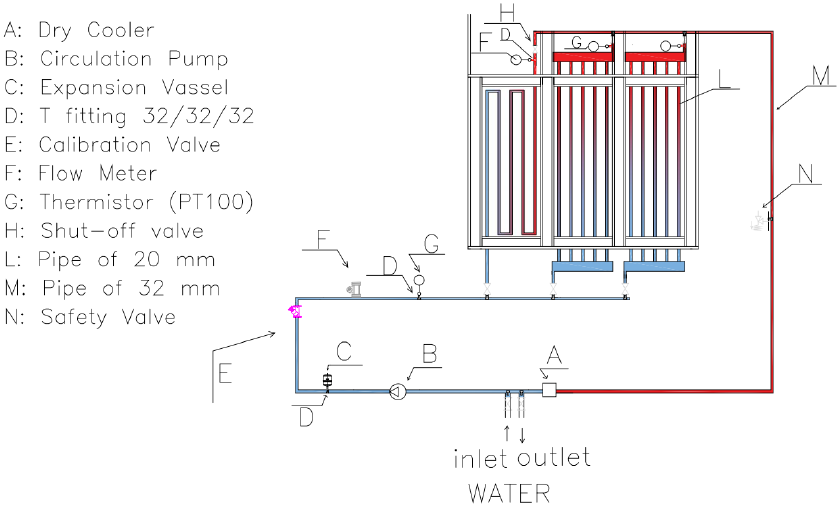
Figure 3. Hydraulic schema.